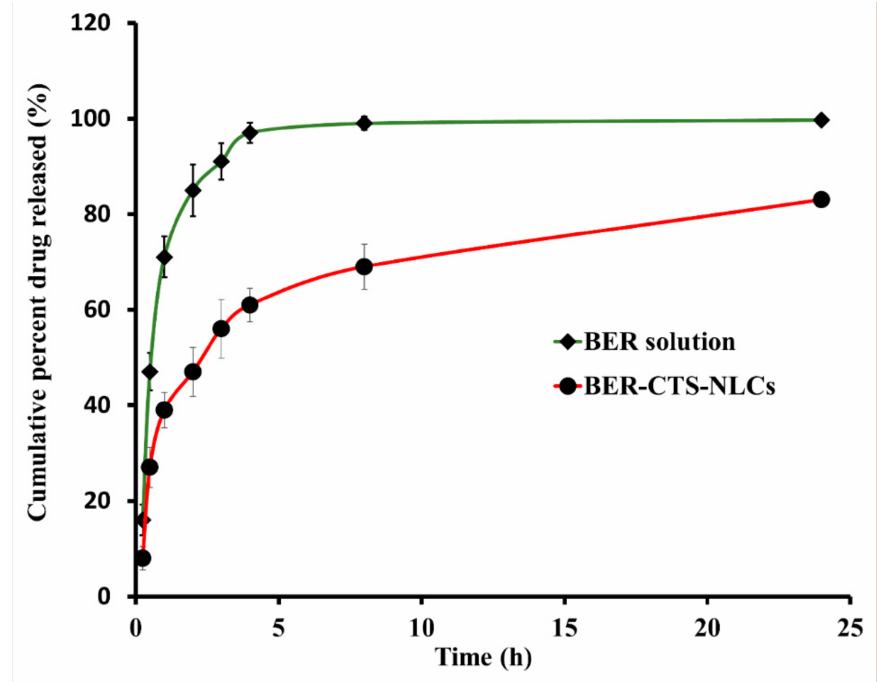
Figure 4. In-vitro release profiles of BER from BER-CTS-NLCs and BER solution.